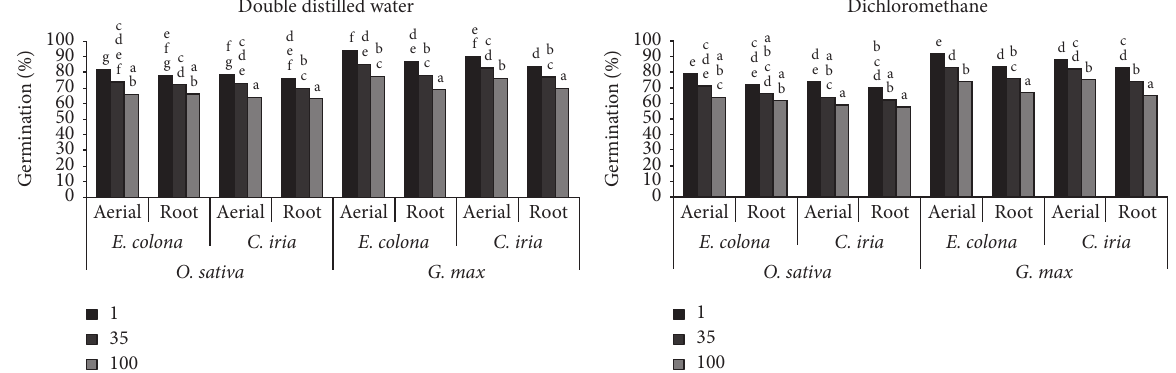
Figure 1: Difference between germination percentage in DDW and DCM extract with respect to different concentration.